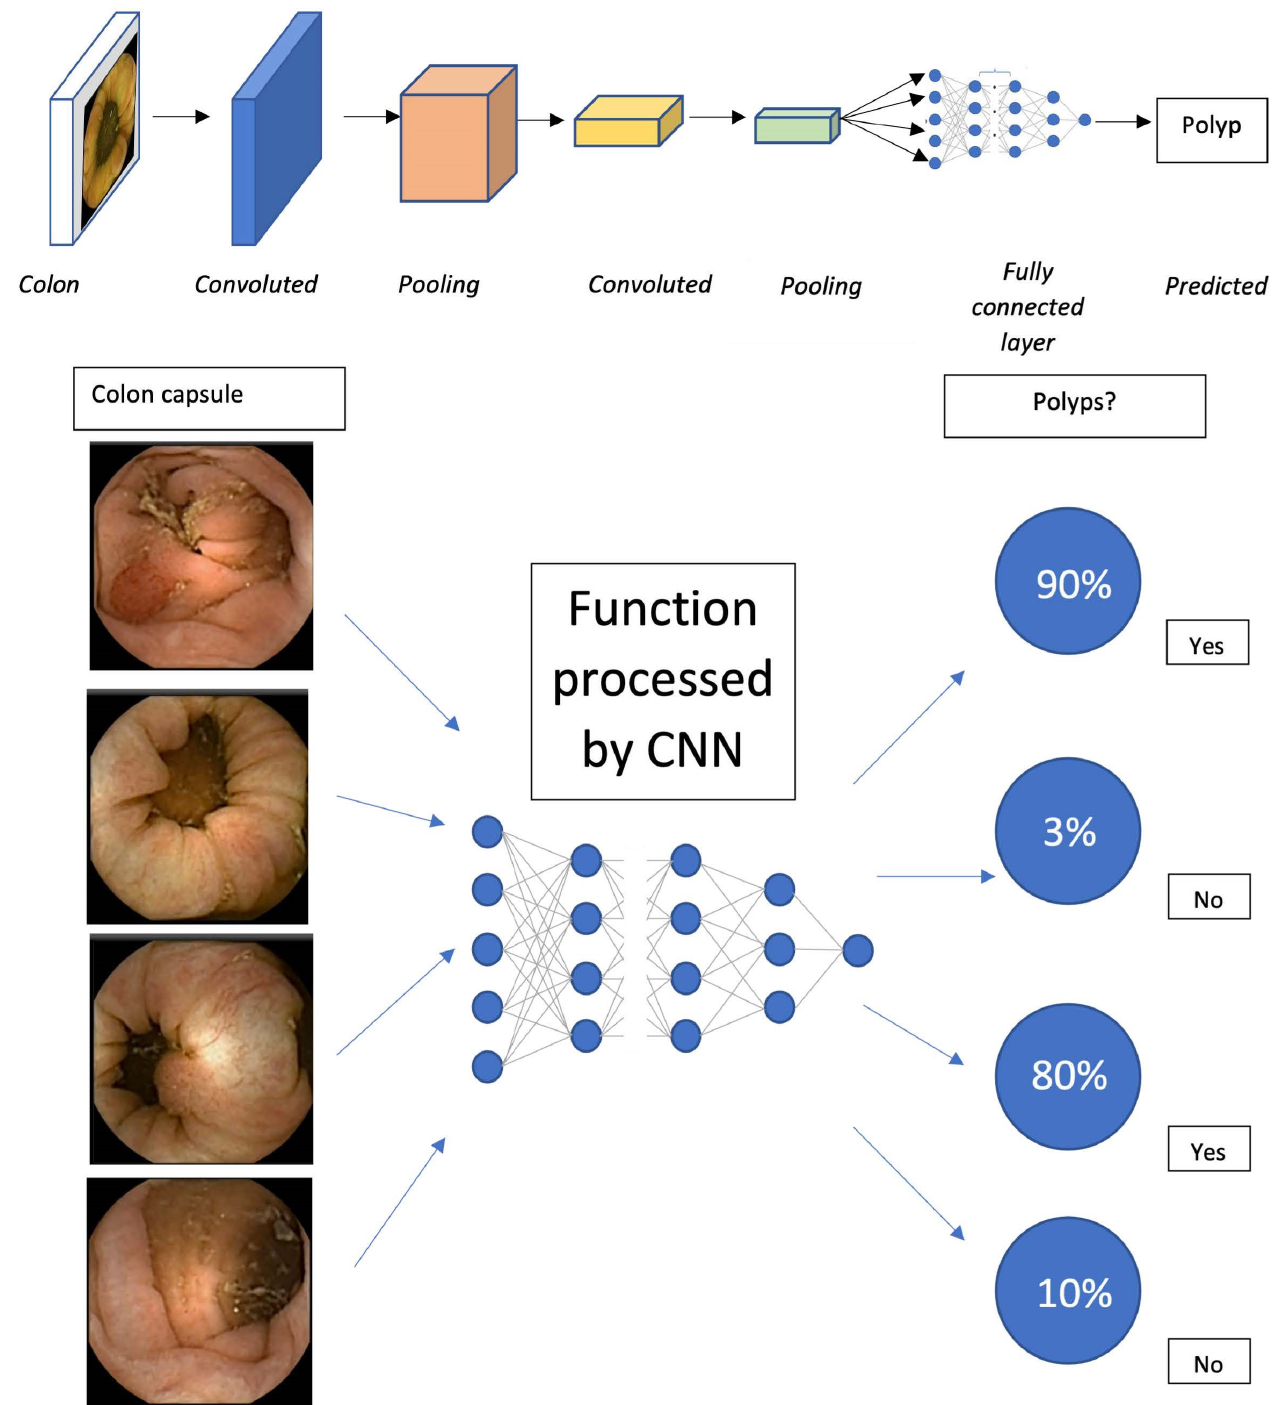
Figure 4. The simplified overall CNN layers in identifying polyps in the CCE video and the flowchart demonstrate the CNN used in the colon capsule video to predict polyps, for example, accurately.